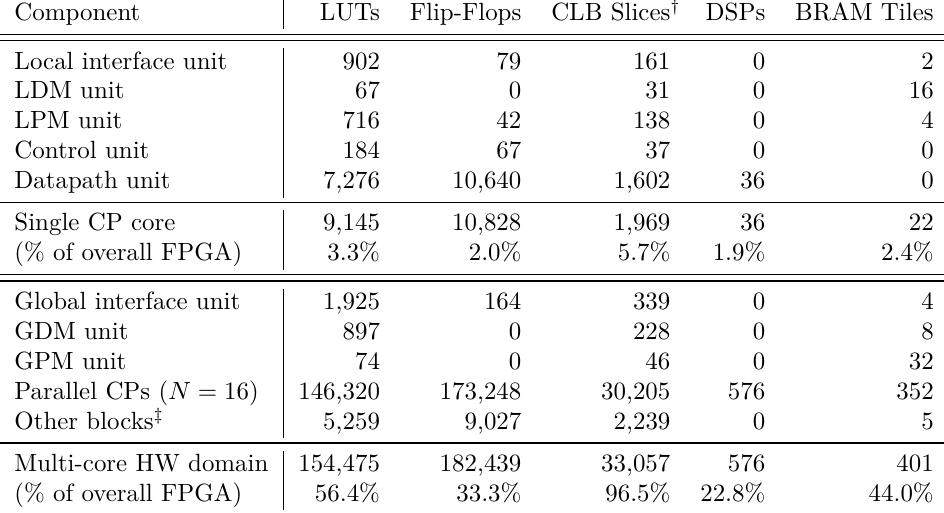
Table 1: Resource requirements of the HW domain (FPGA) in Xilinx Zynq UltraScale+ MPSoC ZU9EG device. The clock frequency constraint was set to 210 MHz in